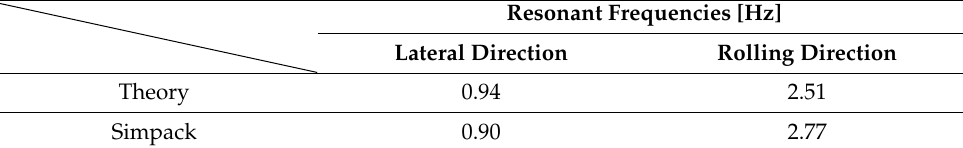
Table 6. The comparison of the resonant frequencies between the theoretical formula and Simpack.